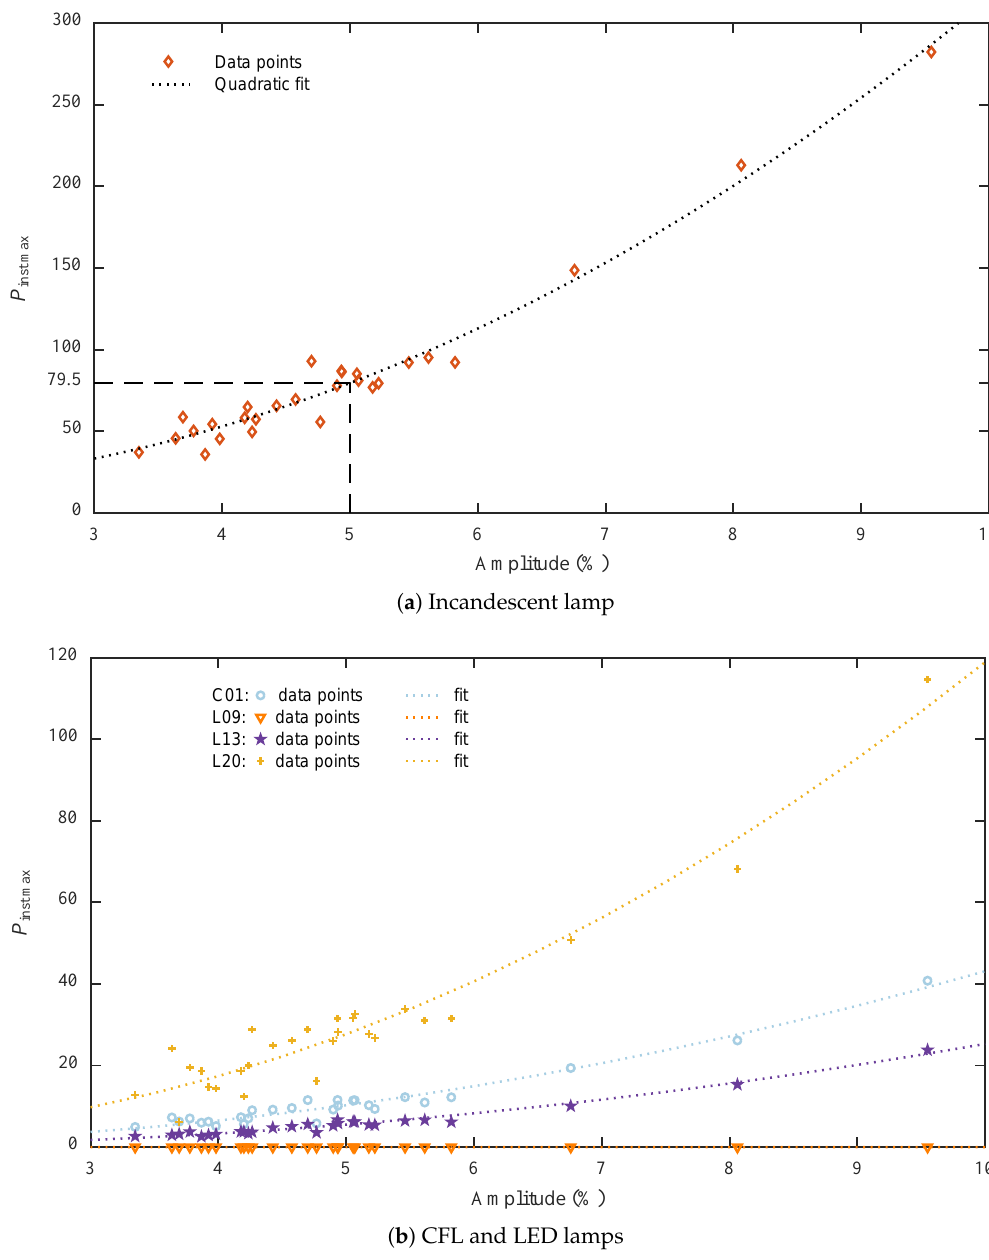
Figure 8. Response of the incandescent lamp ( a ) and CFL and LED lamps ( b ) to instantaneous motor start type